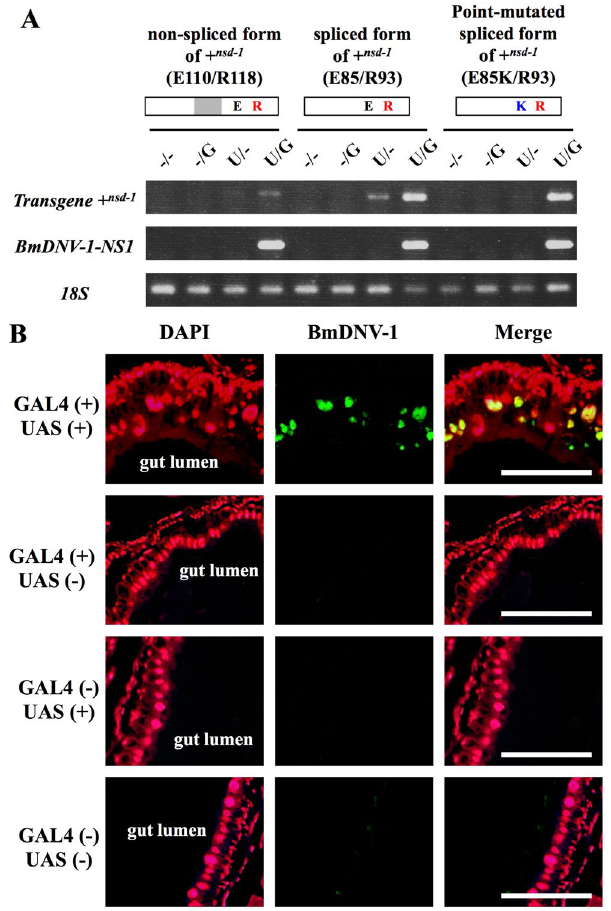
Figure 4. Expression and immunohistochemical analysis in transgenic silkworms. ( A ) RT-PCR of BmDV- derived transcripts and the + nsd-1 transgene in the midgut of transgenic silkworms. Transgenic silkworms carrying the nonspliced form of the susceptibility gene + nsd-1 [glutamic acid (E) at 110 and arginine (R) at 118], the spliced form of + nsd-1 (E at 85 and R at 93), and the point mutated spliced form of + nsd-1 [lysine (L) at 85 and R at 93] were generated. K (blue) and R (red) indicate the amino acid residue conserved in resistant and susceptible strains, respectively. − / − , − /G, U/ − , and U/G indicate the wild-type, GAL4, UAS, and GAL4/ UAS lines, respectively. The midgut was dissected from day 3 fifth instar following exposure to BmDV on day 0 of the fourth instar stage. RT-PCR was performed for 30 cycles with primer sets for + nsd-1 , the NS1 gene of BmDV 20 , and ribosomal 18S as a positive control. ( B ) Immunohistochemical analysis of BmDV in the midgut of transgenic silkworms expressing the nonspliced form of the susceptibility gene + nsd-1 . Sections were incubated with anti-BmDV capsid antibody (1:100) followed by a secondary antibody labeled with AlexaFluor488 (1:200) (green) and counterstained with DAPI (1:1000) (red). DAPI staining (left); BmDV signal (center); merge (right). Scale bar: 200 μ